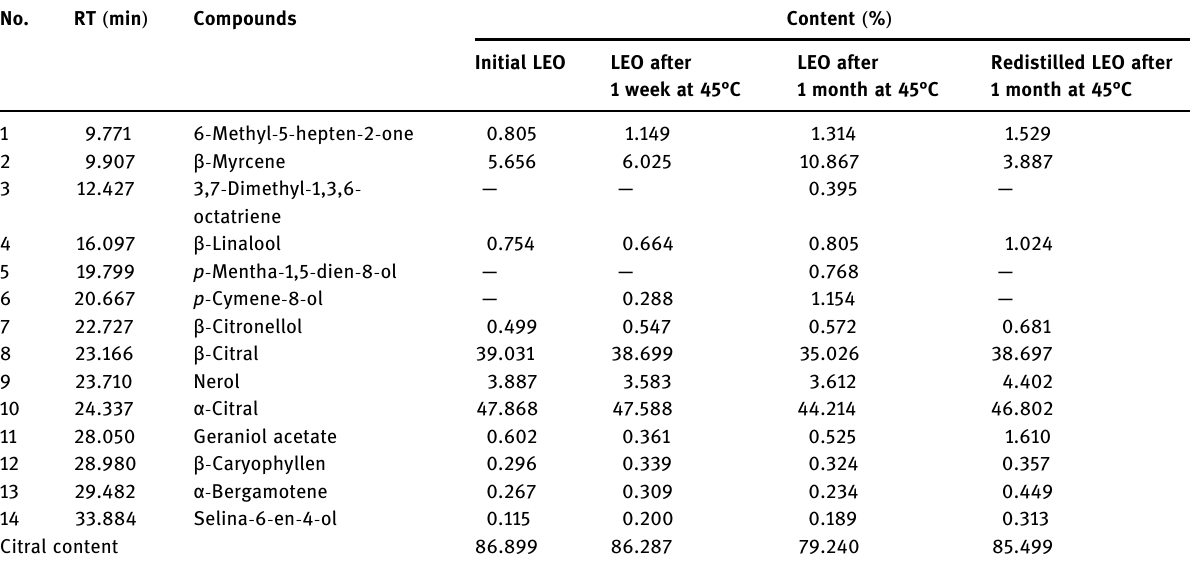
Table 2: Chemical compositions of LEO under di ff erent storage and extraction conditions